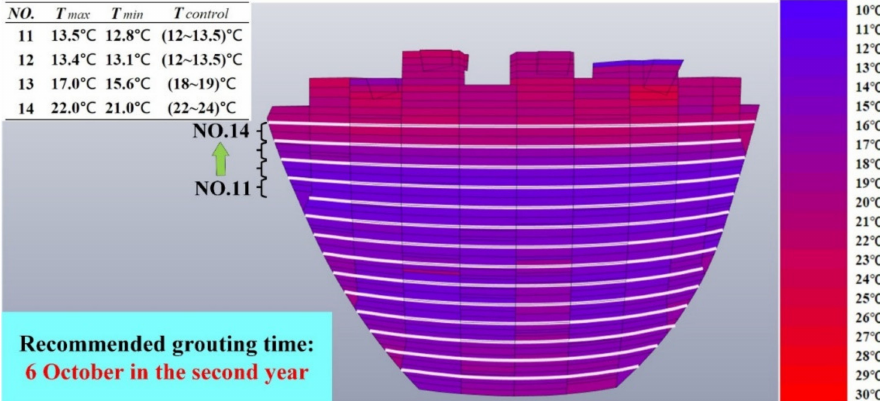
Figure 7. The 3D cloud picture of the temperature field and the recommended time for joint